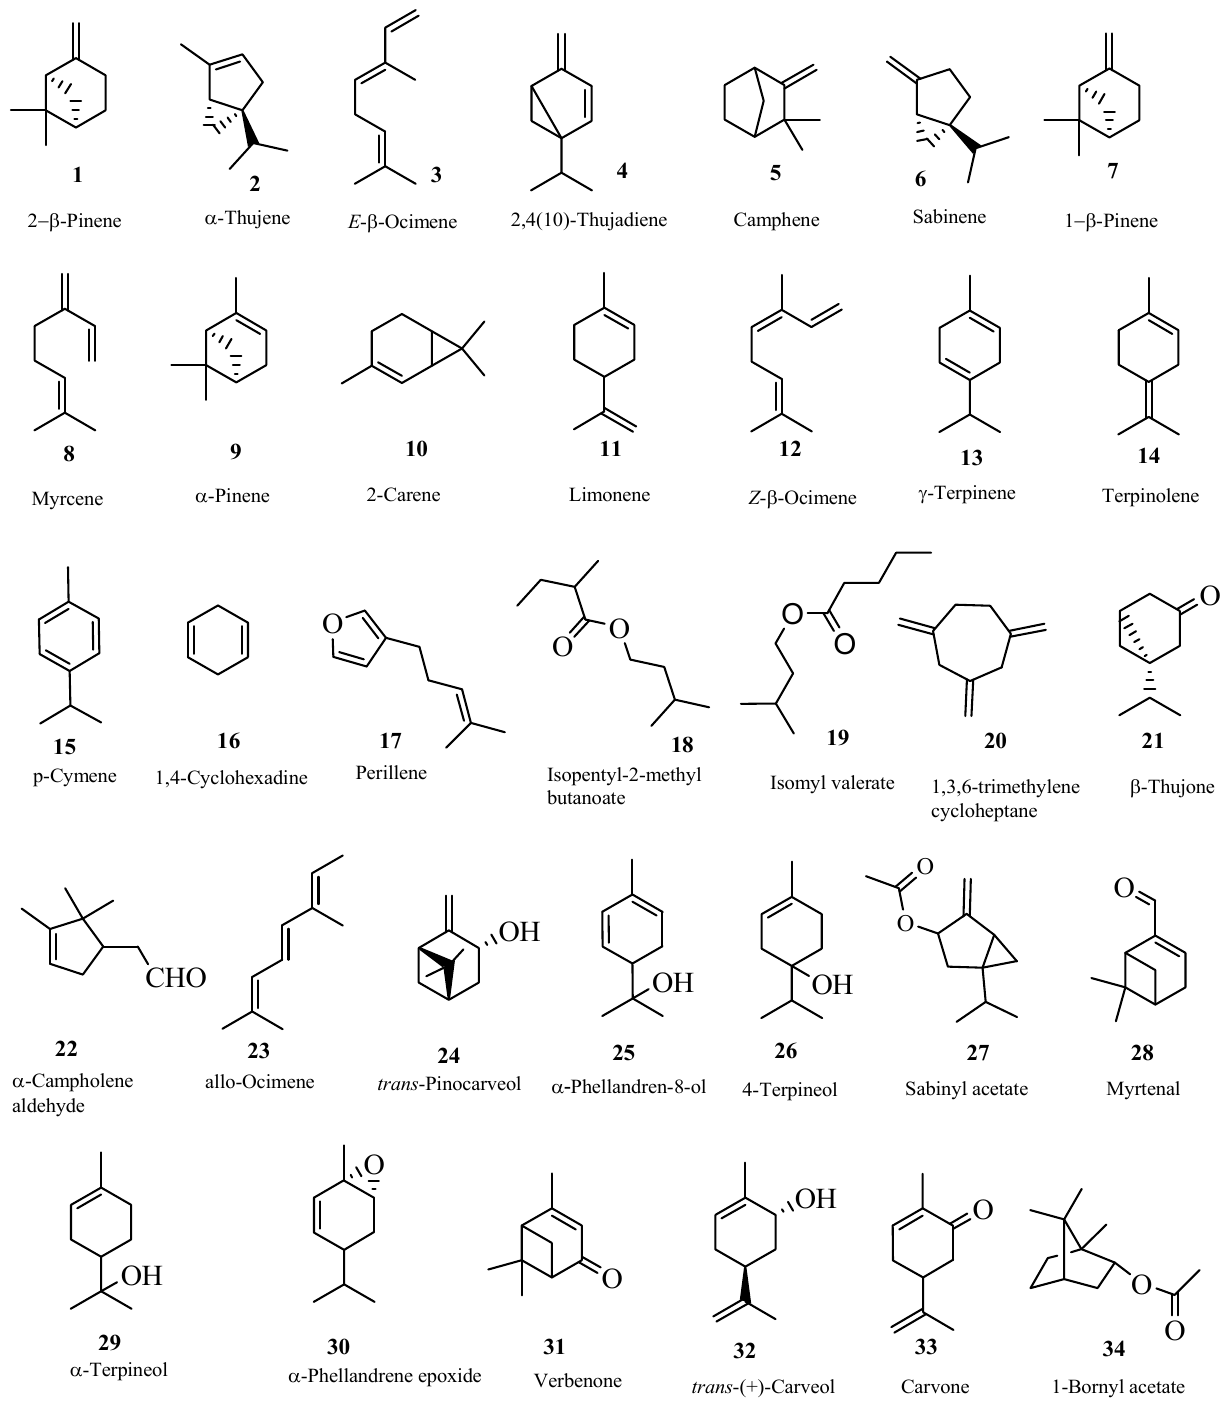
Figure 1. Monoterpenes from the essential oil of the Boswellia sacra